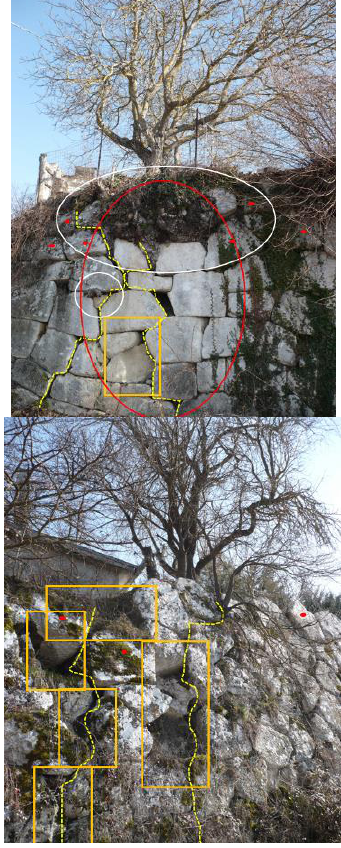
Figure 12. Megalithic retaining walls of the Provincial Road 24 (SP 24 per Alba Fucens): washout phenomena (red